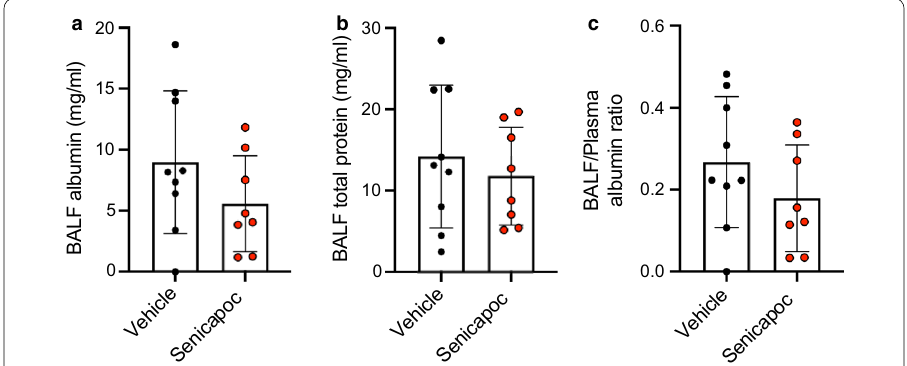
Fig. 3 Administration of senicapoc did not improve alveolar–capillary barrier function. Measurements of a BALF albumin, b BALF total protein and c BALF/plasma albumin ratio. Data are presented as mean Vehicle, n 9 and senicapoc, n 8. BALF, bronchoalveolar lavage = =